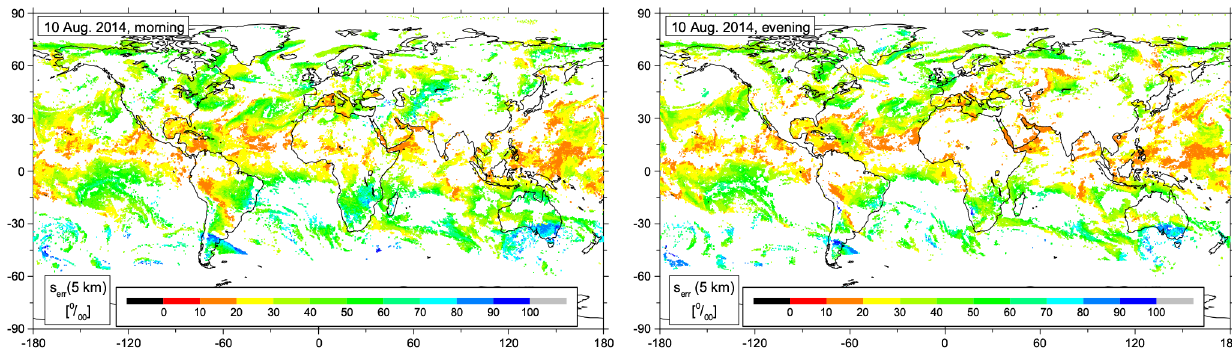
Figure 9. Example of the daily geographical distribution of s err ( 5km ) (calculation of S err according to Eq. 7). Left panels show the morning overpass and the right panels the evening overpass for 10 August 2014.